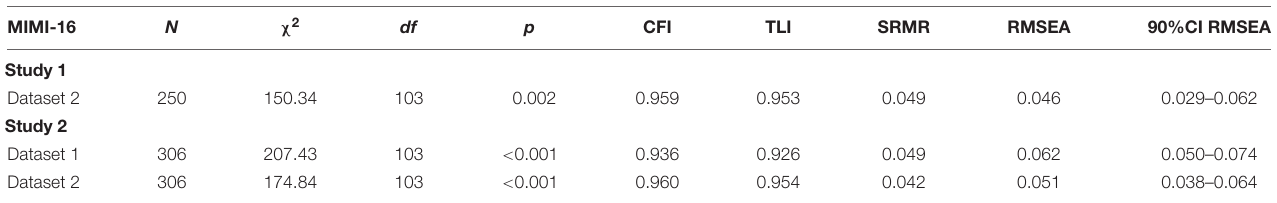
TABLE 4 | Measurement models for MIMI-16 using MLR estimator a